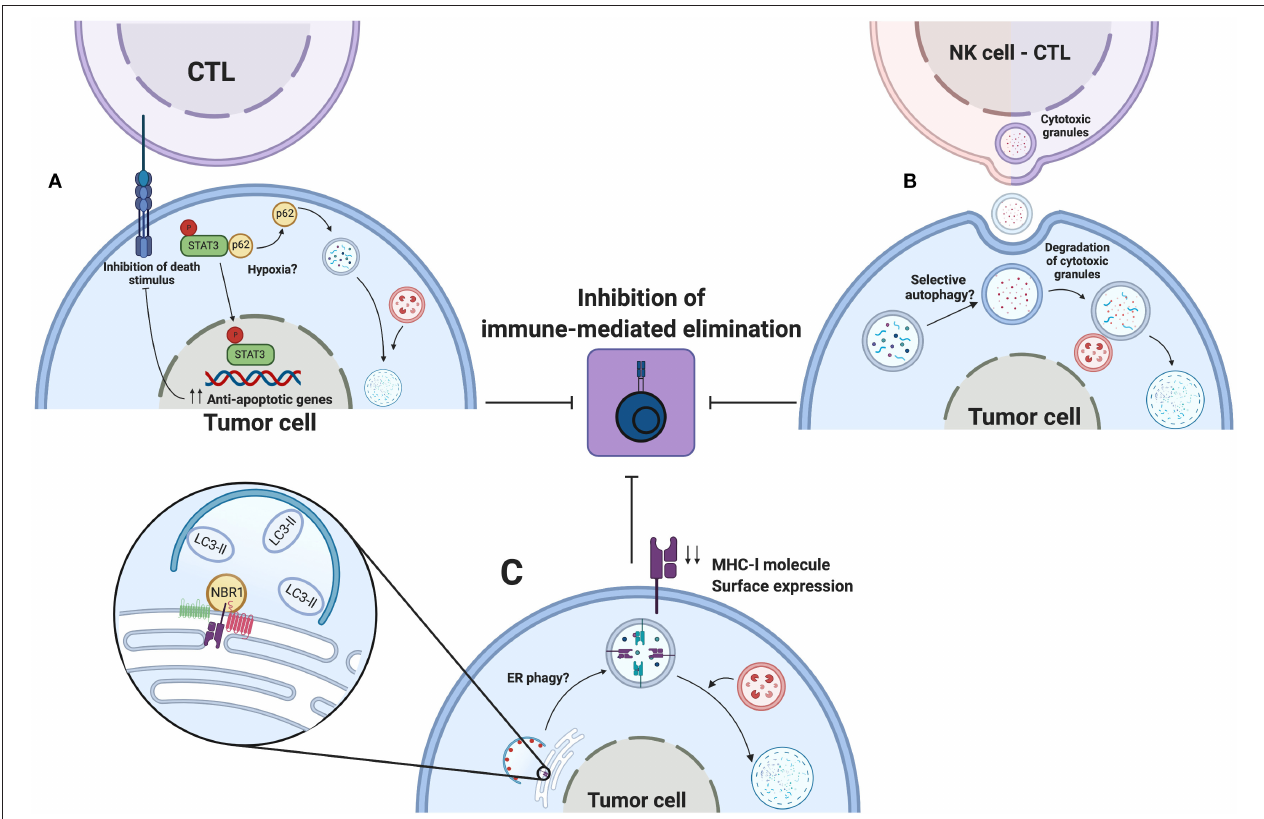
FIGURE 5 | Autophagy as an immune evasion mechanism. Autophagy induced by environmental stress such as hypoxia promotes the escape to CTL or NK mediated elimination of tumors cells. (A) Hypoxia, by an undefined mechanism, releases pSTAT3 from p62, thereby degrading p62 by autophagy and favoring pSTAT3 nuclear localization to up-regulate transcription of antiapoptotic genes. (B) During hypoxia, tumor cells activate autophagy to sequester and degrade cytotoxic granules released by NK cells or CTLs, thus impeding the elimination of tumor cells. (C) Selective ER phagy might participate in degradation of MHC-l molecules during their biogenesis. NBR1 associate to MHC-l molecules or their chaperones in ER. Decreased surface expression of MHC-l molecules leads to impaired recognition by innate or adaptive immune cells, leading to escape for immune-mediated elimination. Created by